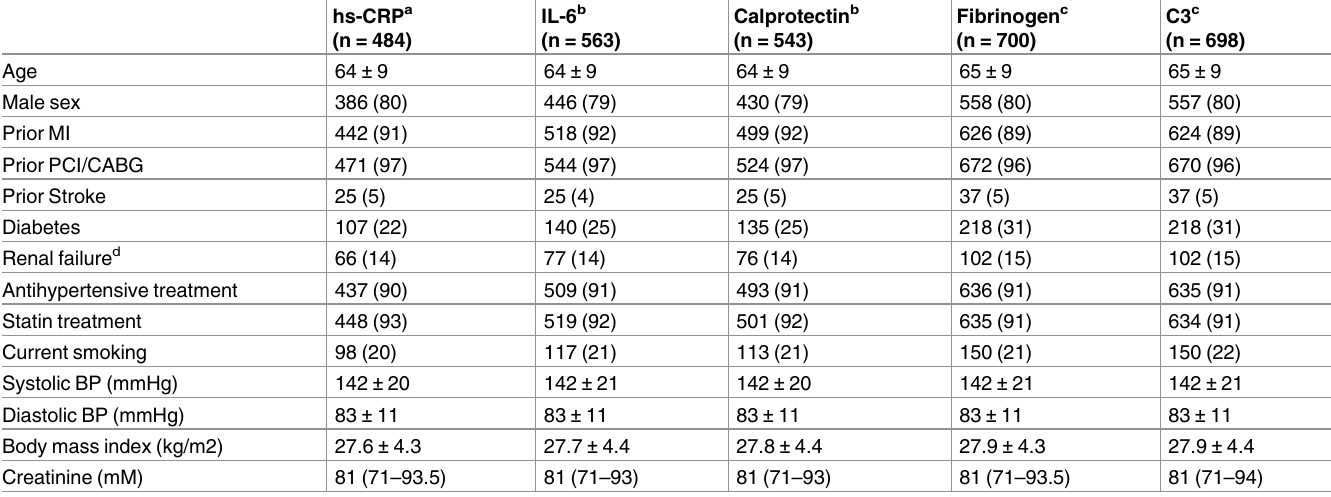
Table 1. Patient